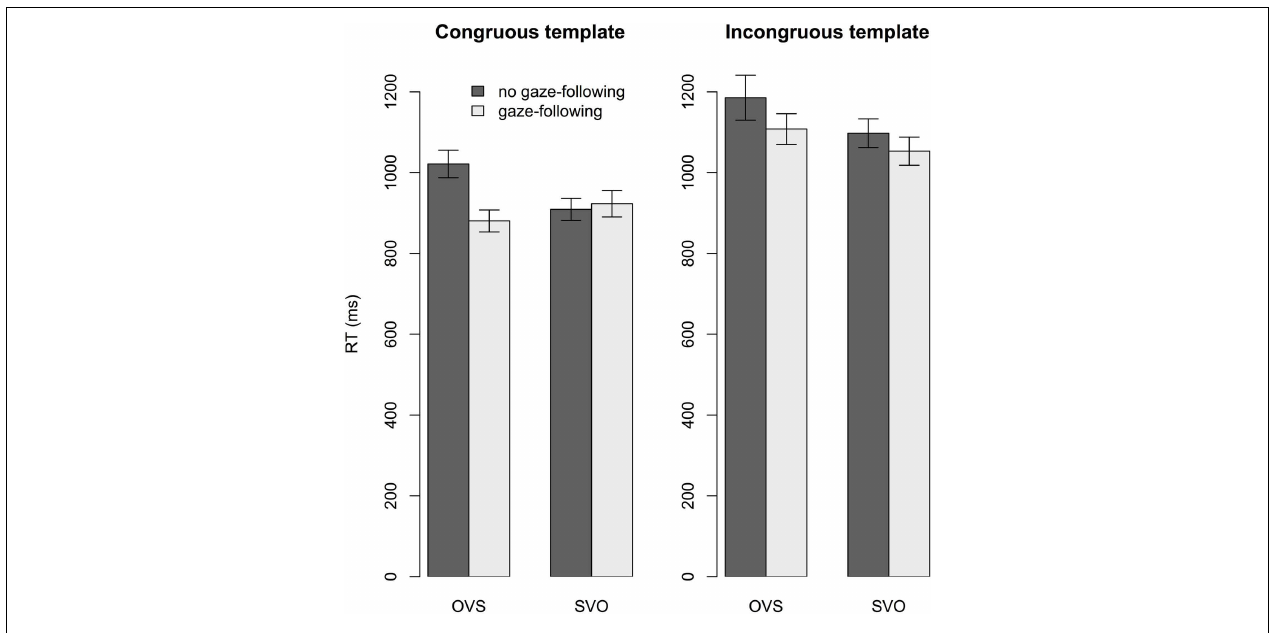
fixated in the SHIFT time window. In these trials, participants’ response times to OVS sentences were shorter than for OVS sentences when they did not follow gaze, but only when the template matched the sentence. Error bars are SE .